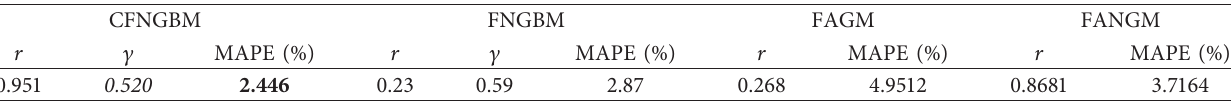
Table 2: The minimum MAPE and optimal order, power index of FAGM(1,1), FANGM(1,1, k , c ), FNGBM(1,1), and CFNGBM(1,1), and CO emissions in China.